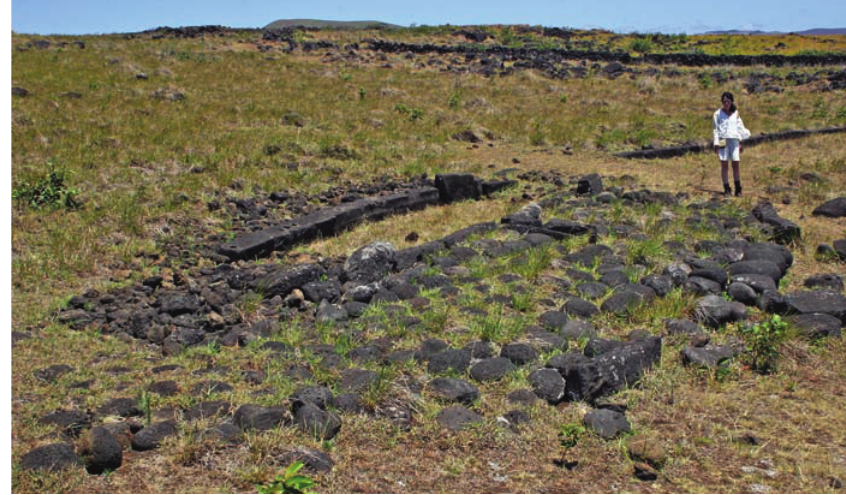
Figure 10 Stone foundation of a boat-shaped house (hare paenga), with an associated poro (sea boulder)